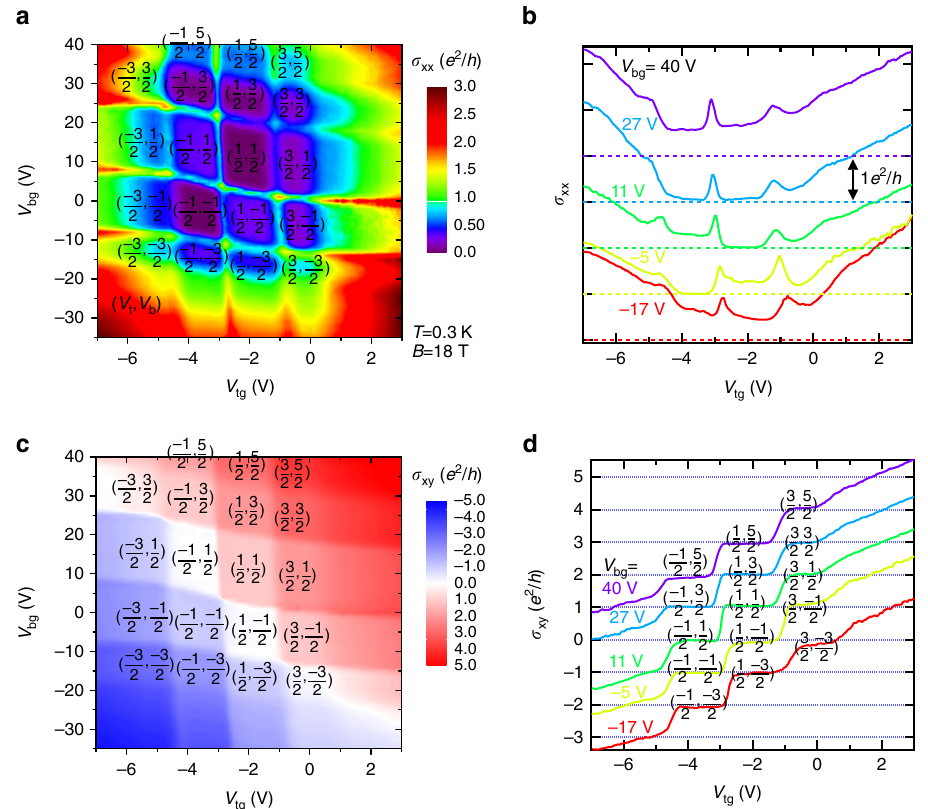
Figure 2 | QHE modulated by top and bottom gates. ( a ) s xx and ( c ) s xy , shown as 2D colour maps, as functions of V tg and V bg at B ¼ 18Tand T ¼ 0.3K in the sample ‘A’, with representative cuts at 5 different values of V bg shown in b and d . The ( n t , n b ) labels (top, bottom) surface filling factors for corresponding quantum Hall states. The s xx curves in b are shifted vertically (in consecutive step of e 2 /h ) for clarity (the corresponding zero s xx levels are indicated by the same-coloured horizontal dashed lines).